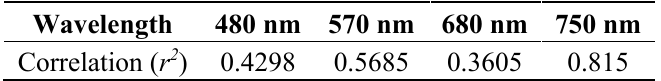
Table 6. Correlation of modeled data with measured data for all tilt angles at specific